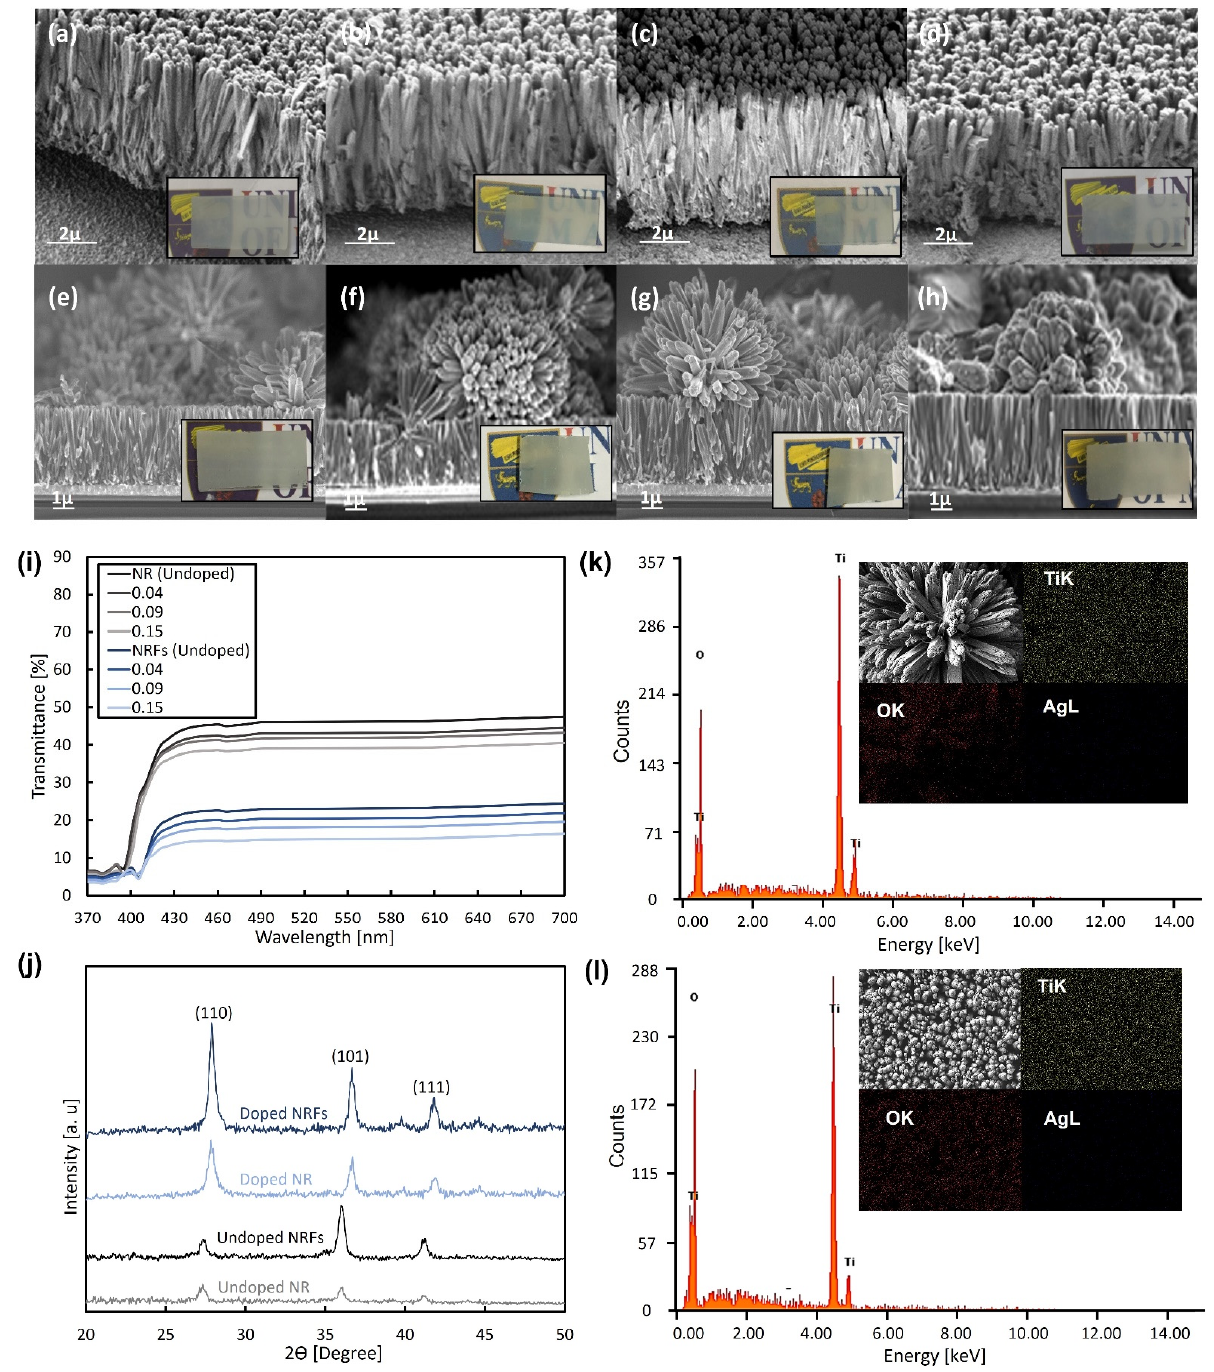
Figure 1. FESEM images of NR samples for ( a ) 0, ( b ) 0.04, ( c ) 0.09, and ( d ) 0.15 wt.% of AgNO 3 , and NRFs samples for ( e ) 0, ( f ) 0.04, ( g ) 0.09 and ( h ) 0.15 wt.% of AgNO 3 . The insets show photographs of each sample. ( i ) Transmission spectra of the synthesized NR and NRFs samples with additions of 0, 0.04, 0.09, and 0.15 wt.% of AgNO 3 . ( j ) XRD patterns of the synthesized NR and NRFs samples for 0 (undoped) and 0.15 (doped) wt.% of AgNO 3 . EDX spectrum of ( k ) NRFs and ( l ) NR samples with 0.15 wt.% of AgNO 3 . The insets show FESEM images and elemental mapping of Ti, O and Ag for each sample. (NR sample: single layer consisting of nanometer-sized rod TiO 2 and NRFs sample: bilayer consisting of nanometer-sized rod and flower of TiO 2 ).